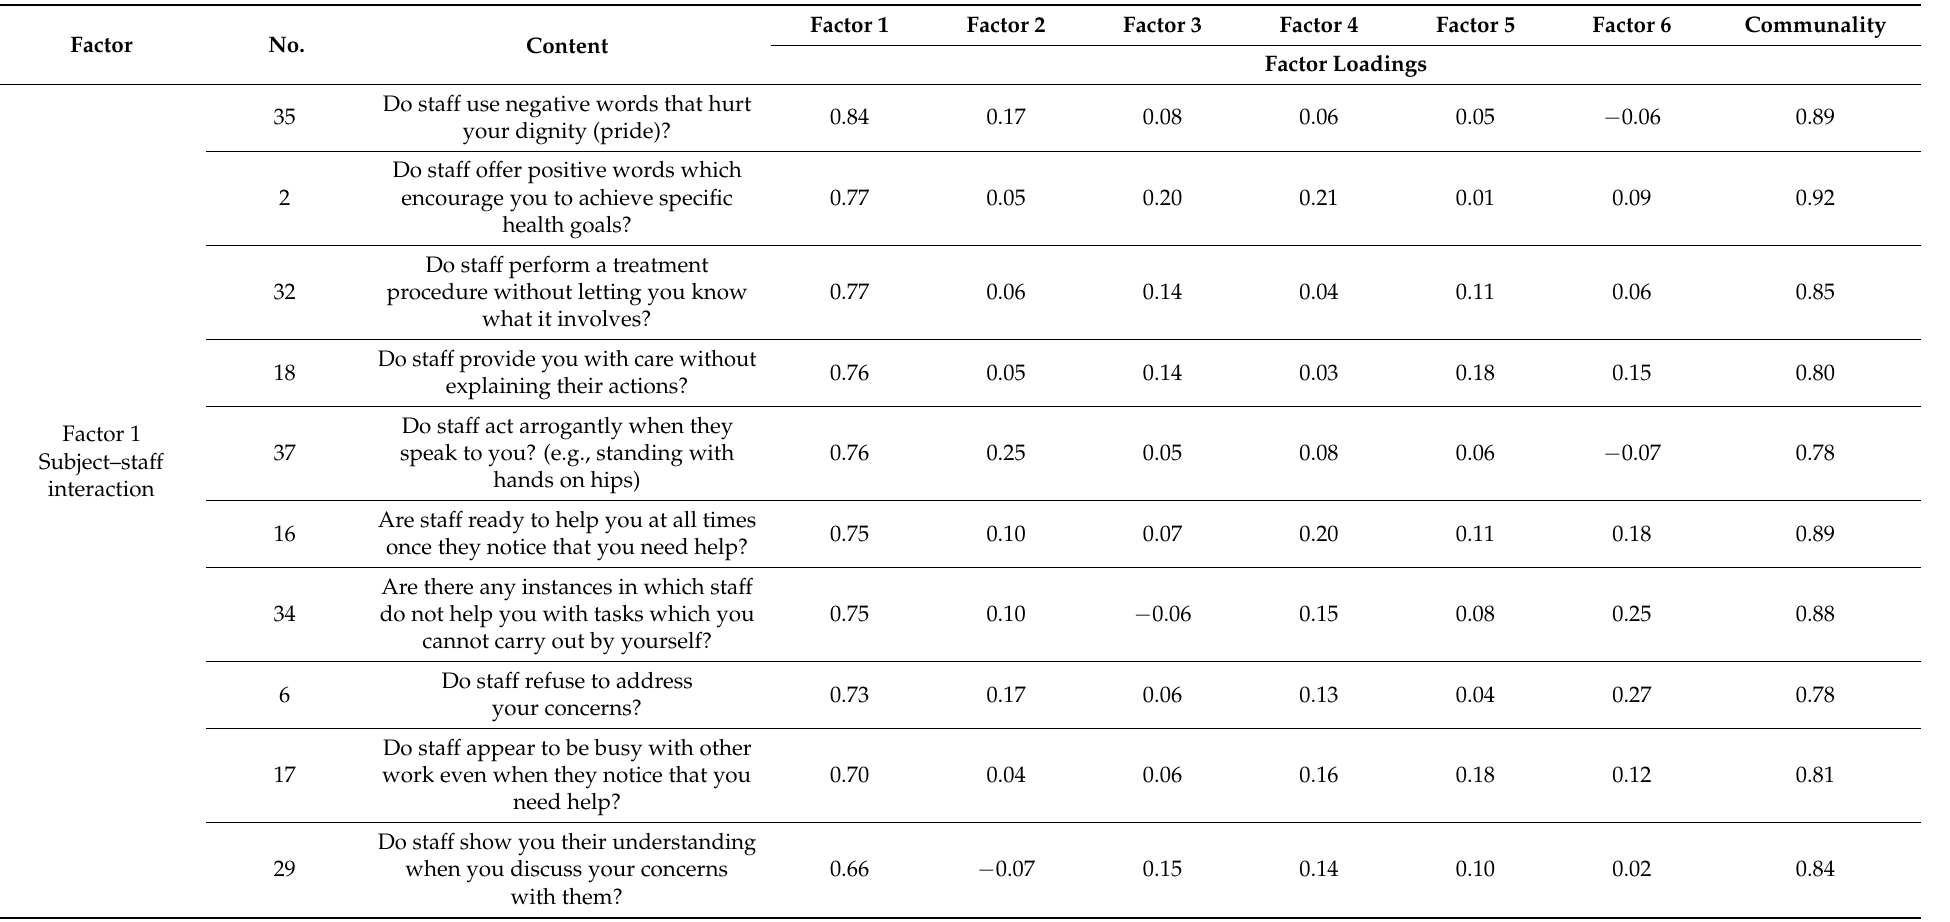
Table 3. Structural validity of the 37-item